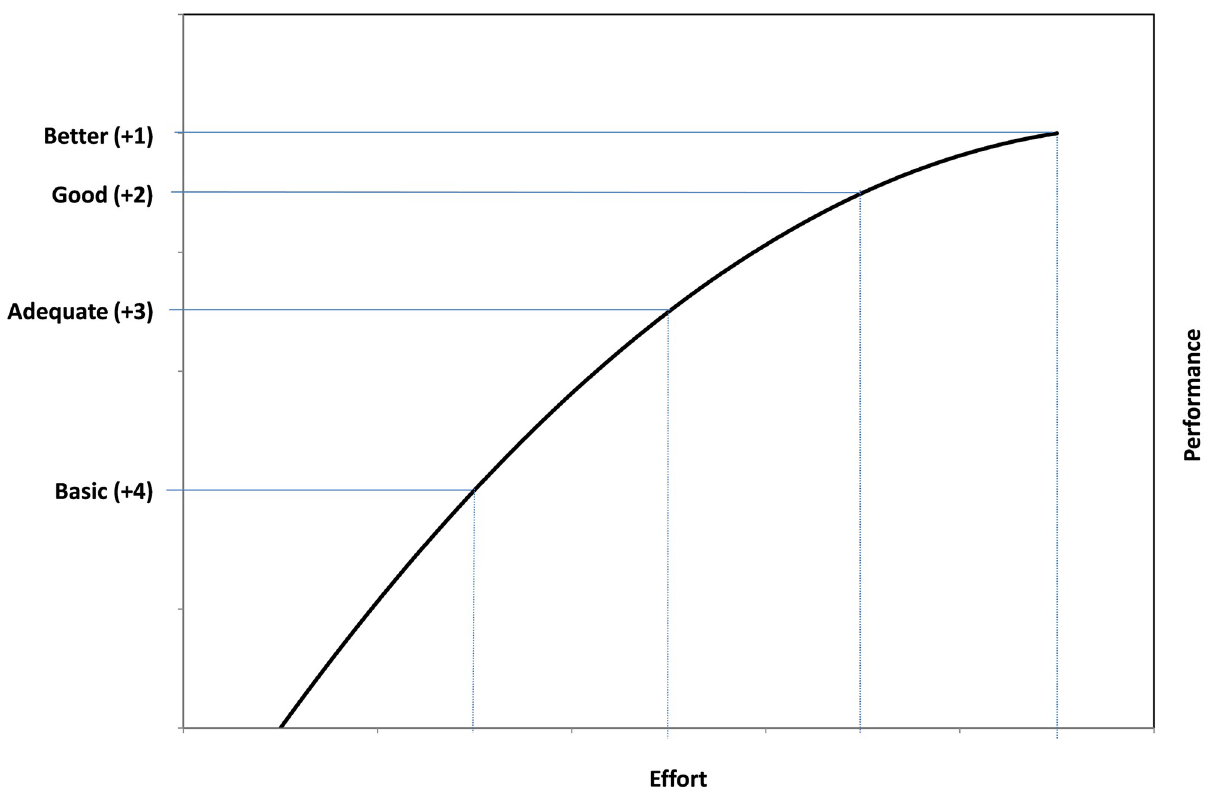
Fig 2. A stylized fisheries improvement curve showing the grades basic, adequate, good and better for measures in the FGT; the greatest improvement per unit of effort is at the lower end of the curve. In this case “effort” is a nominal measure that in practice will vary between indicators, but in some instances may simply equate to cost (e.g., in the implementation of more sophisticated monitoring